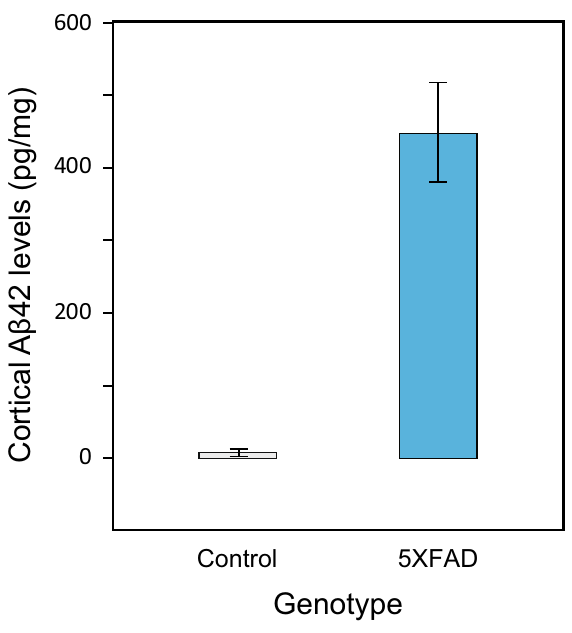
Figure 2. Cortical Aβ42 levels (pg/mg) in the 5XFAD mice and their littermate controls (assessment age = 343 days). There was a significant main effect of genotype on cortical Aβ42 levels. Reported mean values for each condition have been averaged across the rest of the independent variables. The error bars represent standard error of the mean.